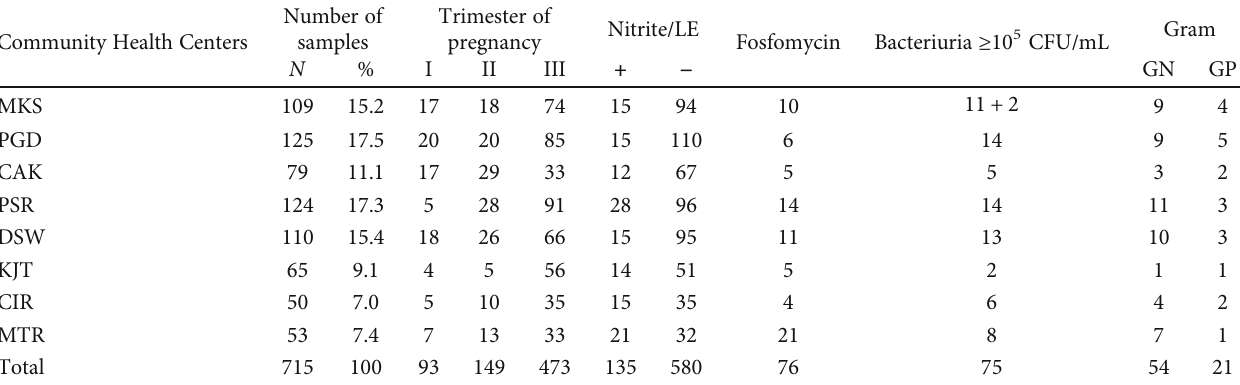
Table 1: Characteristics of urine samples for enrolment of antibiotic susceptibility testing. Community Health Centers